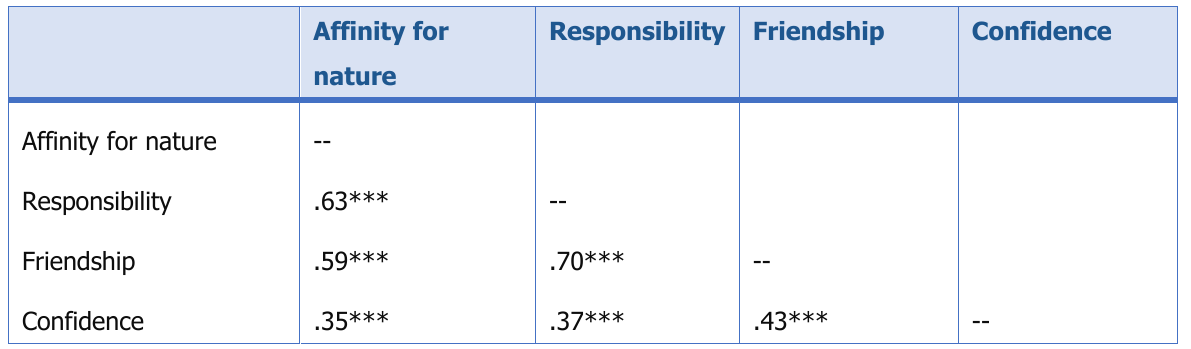
Table 3. Correlations among Survey Outcomes from Summer